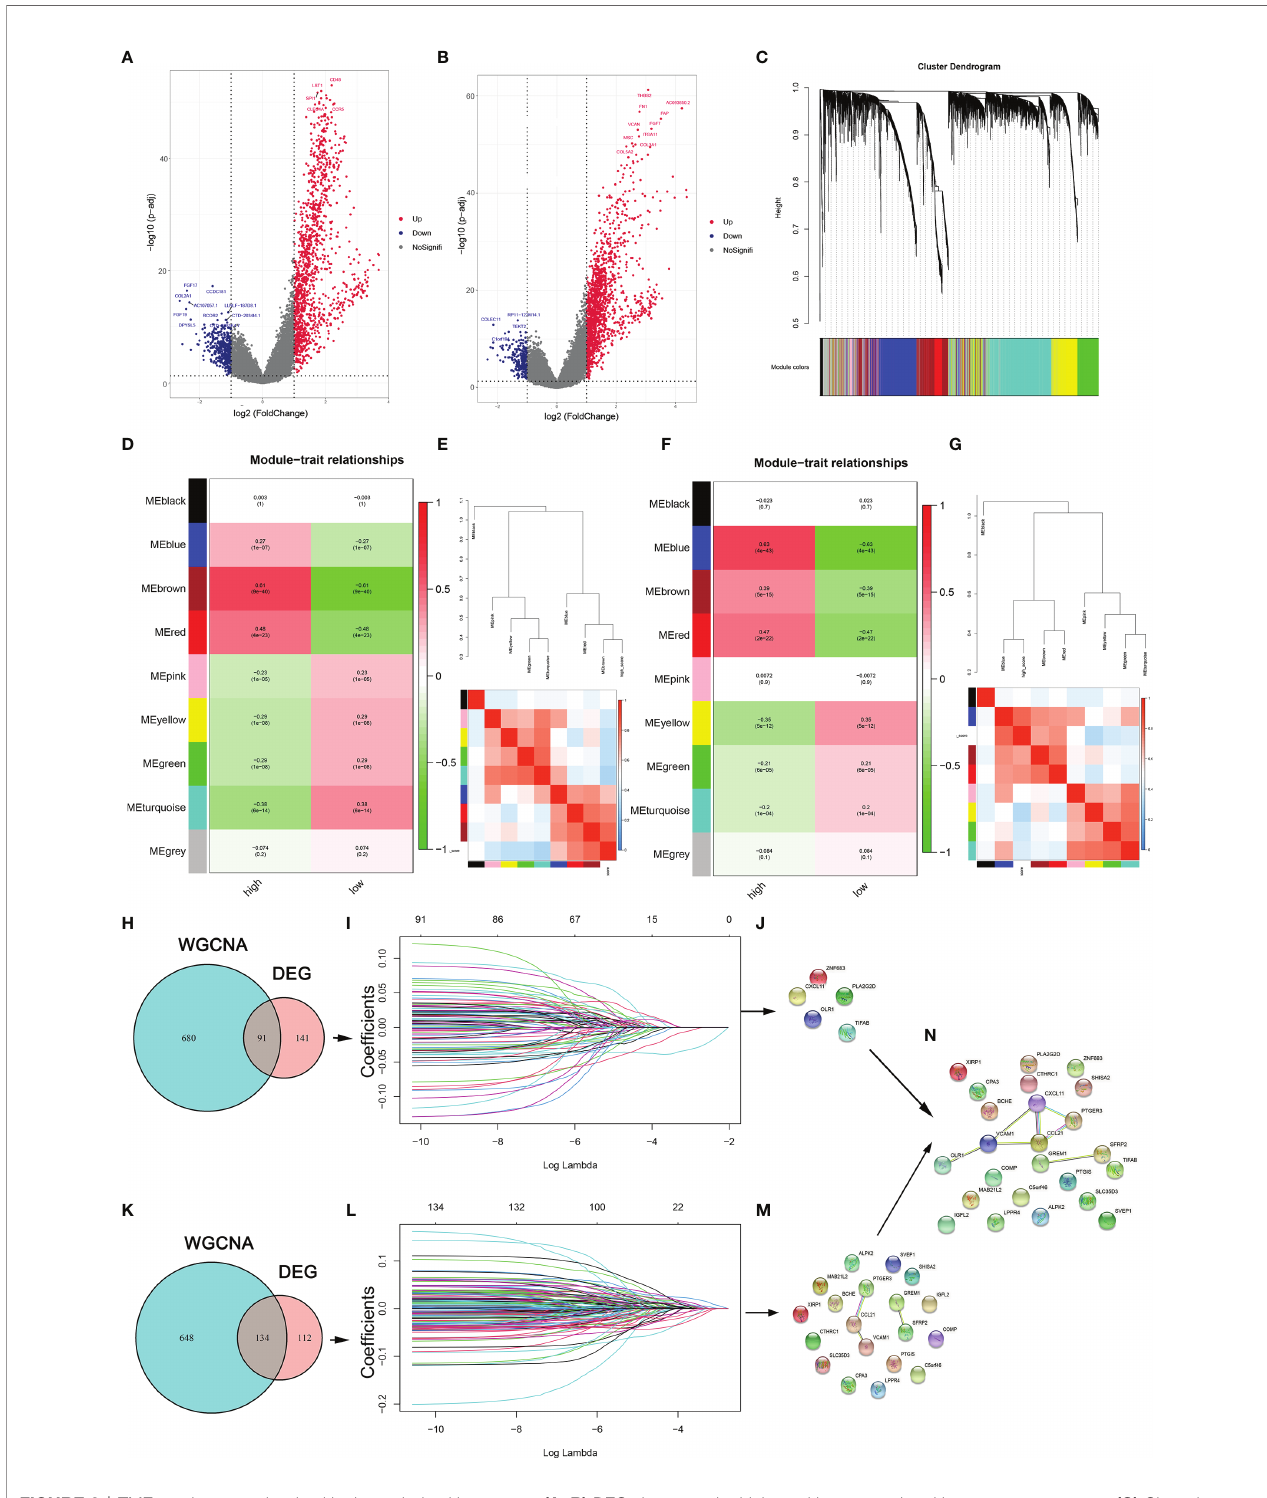
FIGURE 3 | TME regulators are involved in the periodontitis process. (A, B) DEGs between the high- and low-stromal and immune score groups. (C) Clustering dendrograms of genes premised on dissimilarity topological overlap and module colors. (D, F) Scatter plots of immune and stromal genes signi fi cantly related to module membership. (E, G) Dendrogram of consensus module eigengenes and heatmap plot of the contiguities of modules for immune- and stroma-related genes. (H, K) Venn plot shows the number of intersecting immune- and stroma-related genes from DEG analysis and WGCNA. (I, L) LASSO analysis for choosing alternate genes associated with stromal and immune scores. (J, M) The signi fi cant genes are selected from immune-related genes and immune-related genes. (N) The genes are identi fi ed as the critical regulators in